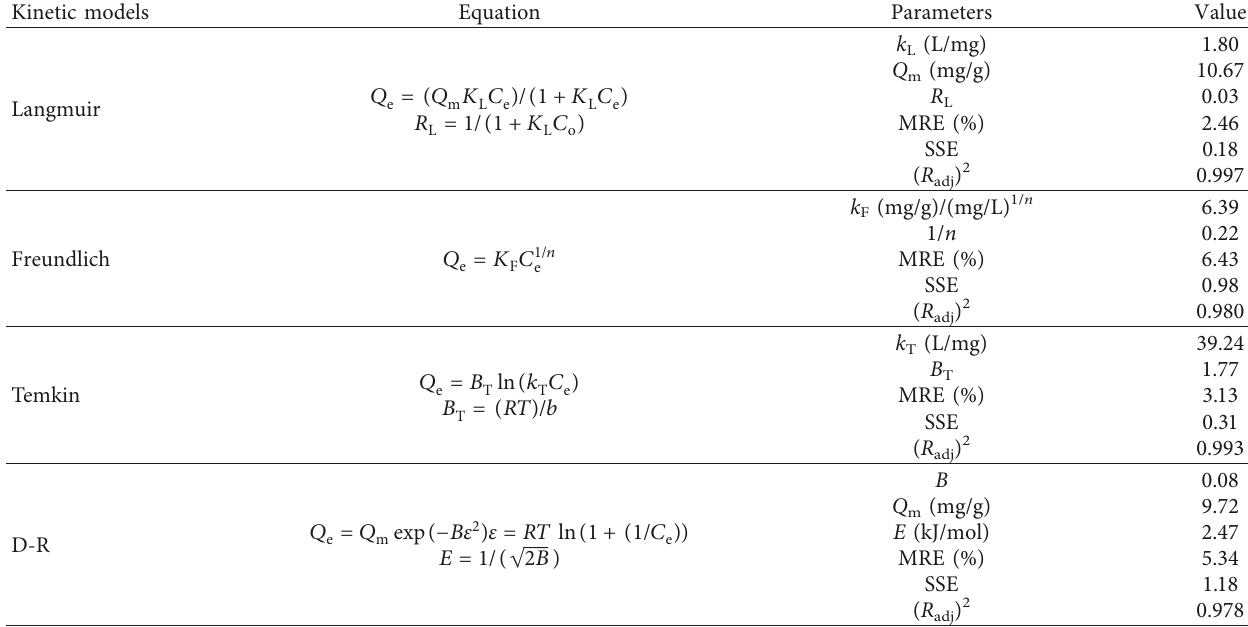
Table 7: Nonlinear isotherm constants for the adsorption of IBU over MIL-53(Fe). Kinetic